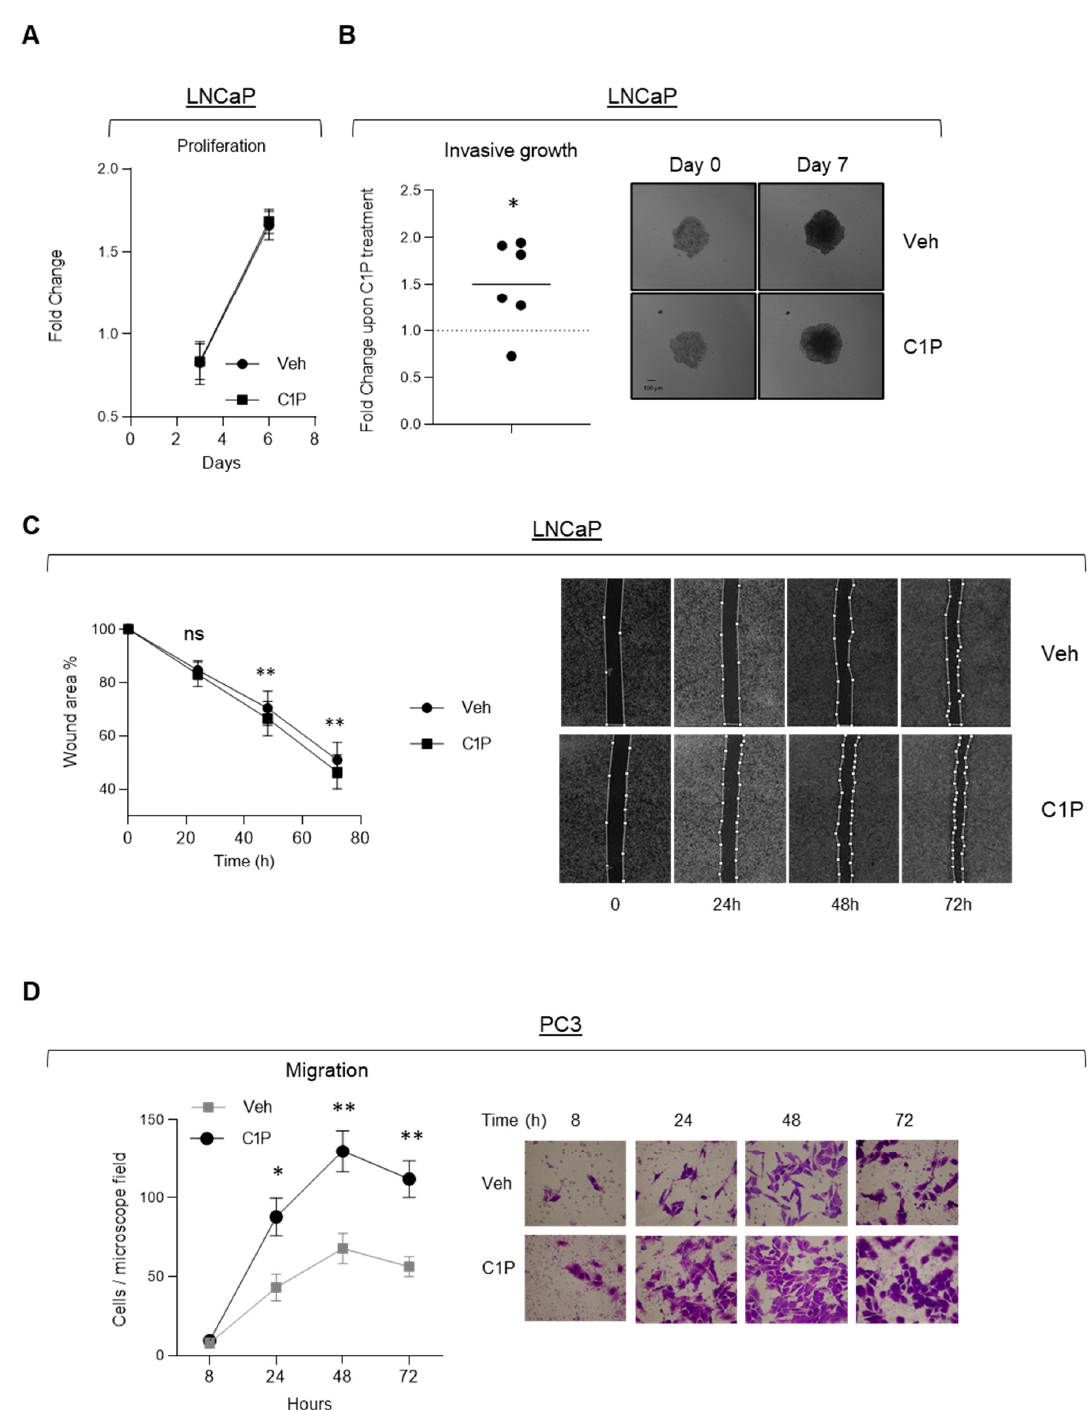
Figure 4. C1P promotes prostate cancer cell migration and invasive growth. ( A ) Proliferation upon treatment with 20 µM ceramide-1-phosphate (C1P) in LNCaP cells ( n = 3 independent experiments). Paired t -test. Comparisons made versus vehicles. ( B ) Quantification of spheroid diameter increase upon treatment with 20 µM C1P in LNCaP cells compared to vehicle (Veh) ( n = 6 independent experiments), one-sample t -test, and representative images of the spheroids at seeding and the end of the experiment. ( C ) Quantification of wound healing migration assay upon treatment with 20 µM C1P in LNCaP cells compared to vehicle (Veh) ( n = 3 independent experiments, paired t -test), and representative images of the wound area at seeding and at the different measured time points. ( D ) Quantification and representative images of cell migration upon treatment with 20 µ M C1P in PC3 cells compared to vehicle (Veh) ( n = 4 independent experiments). Unpaired t -test. All comparisons are two-tailed. * p < 0.05; ** p <